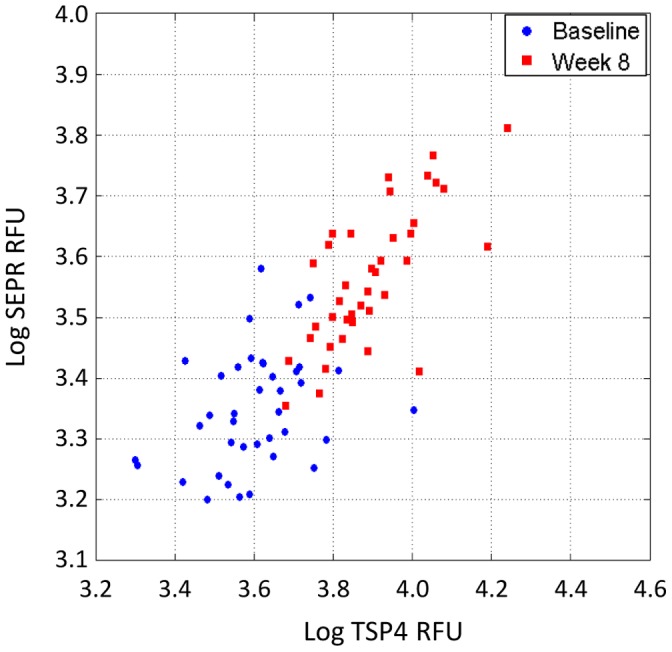
Scatter plot of the separation of baseline and week 8 samples using the two markers with the largest KS distances.